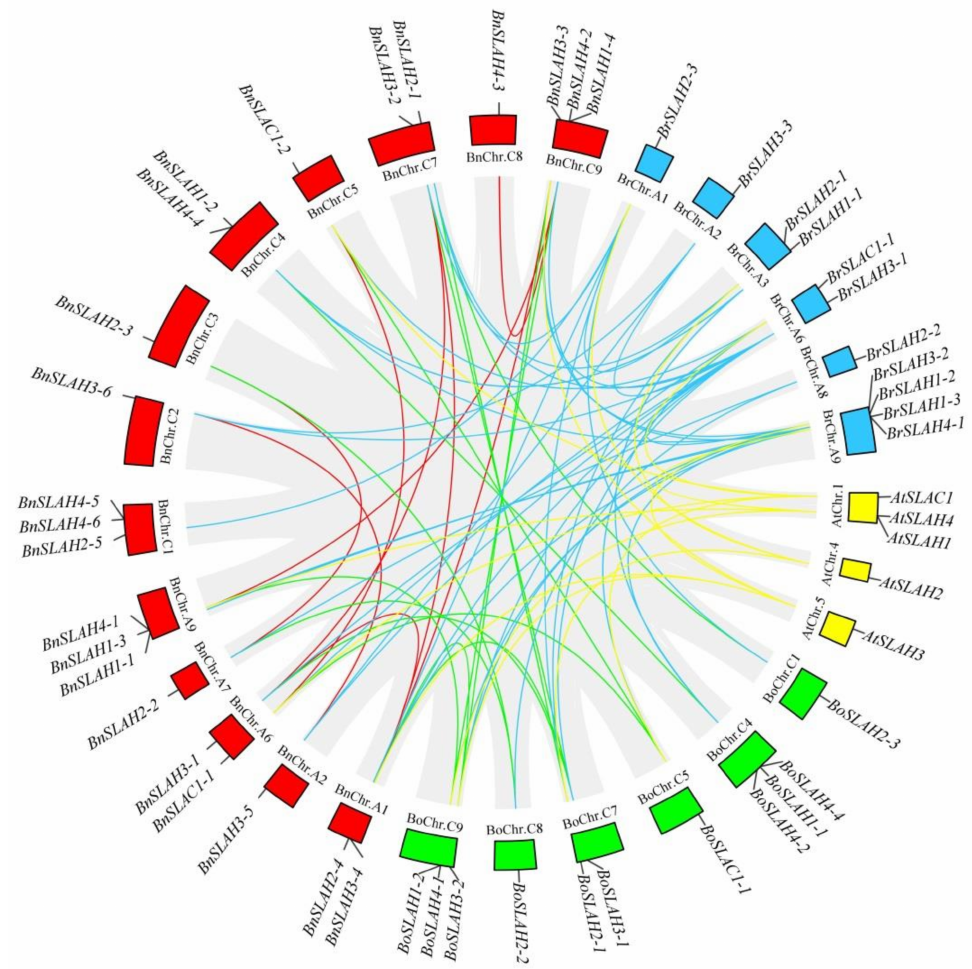
Figure 5. Syntenic relationships of SLAC/SLAH genes among B. napus , B. rapa , B. oleracea and Arabidopsis . The circular forms of Brassica species and Arabidopsis chromosomes are shown in different colors. The approximate positions of the SLAC/SLAH genes are marked with short black lines on the circles. Gene pairs with syntenic relationships are joined by the colored